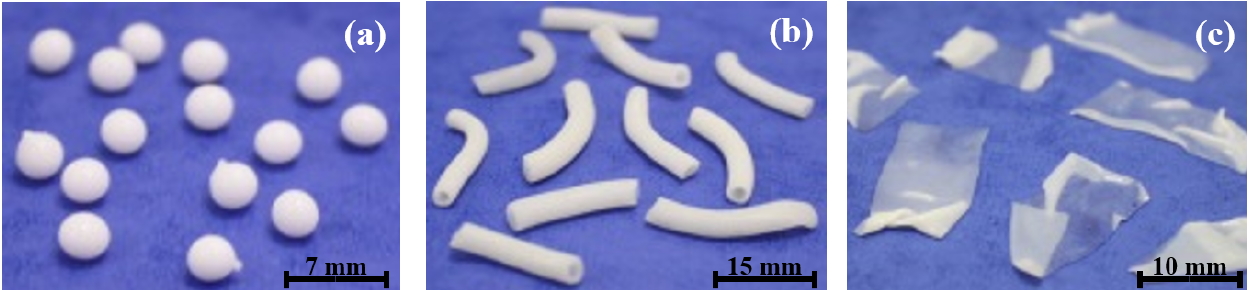
Figure 1. Photographs of media used in the study: ( a ) beads, ( b ) hollow cylinders, and ( c ) sheets. The physical properties of the QQ media are summarized in Table Table 1. Properties of the solid media. Solid Medium Beads Hollow Cylinders Sheets Dimensions (mm) Diameter: 3.5